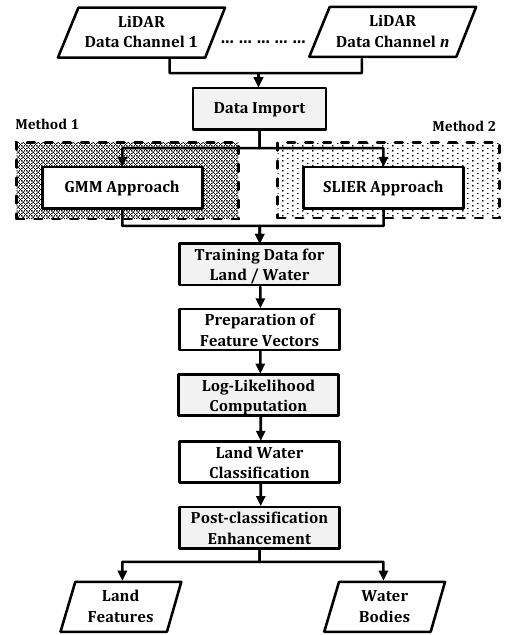
Figure 1. Overall workflow for automatic land-water